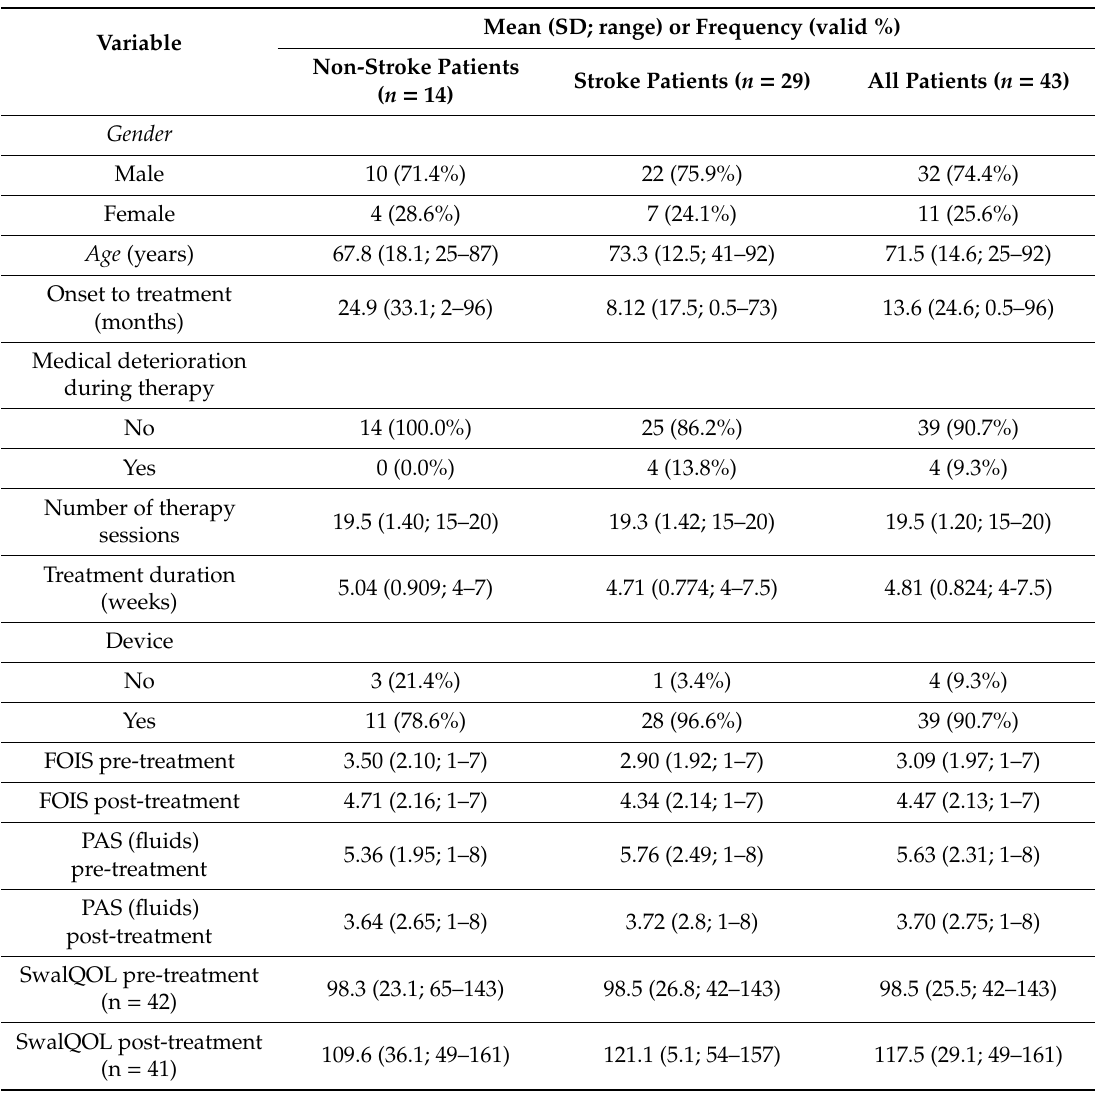
Table 6. Descriptive summary of total sample (new data plus Sproson et al., 2018